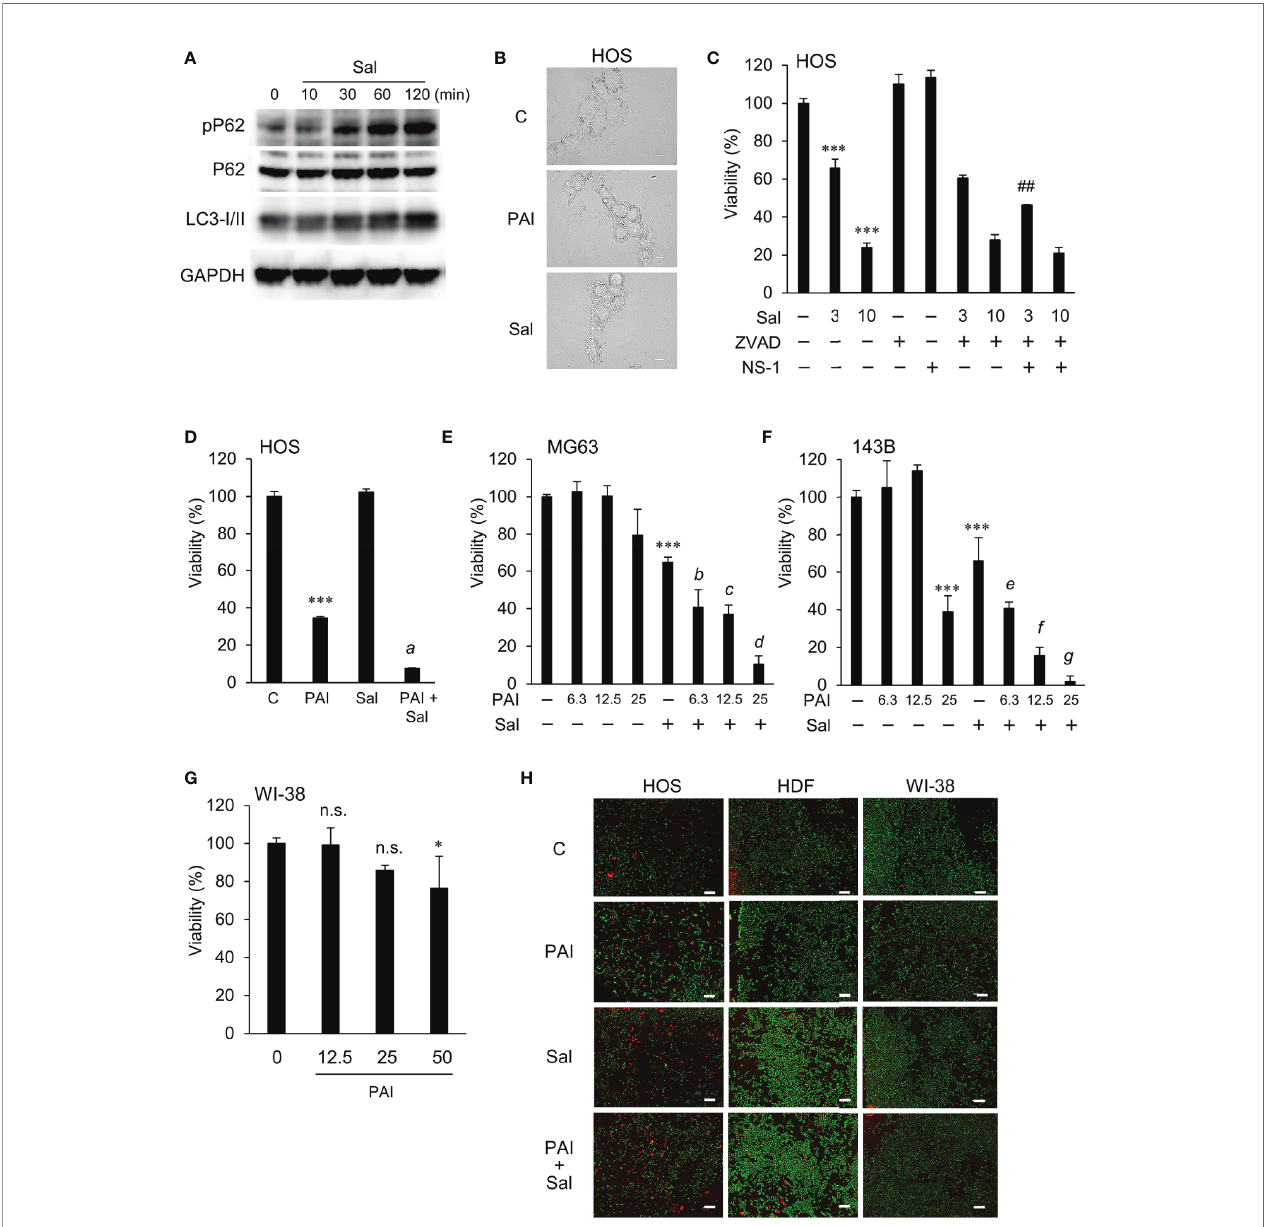
FIGURE 4 | PAI and Sal mutually act as adjuvant in a tumor-speci fi c manner. (A) LM8 cells were treated with Sal (1 m M) for the indicated time and then analyzed for the expression of phosphorylated P62, P62, and LC3-I/II by western blotting analysis using speci fi c antibodies. GAPDH was used as the loading control. See Supplementary Figure 5 for examples of uncropped images and quanti fi cation for each antibody. (B) HOS cells were treated with PAI (25%) and Sal (3 m M) for 18 h and observed under a BZX-710 digital biological microscope equipped with a 100×coverslip-corrected oil objective and were analyzed using BZ-H3A application software. Bar = 10 m m. (C) HOS cells were treated with Sal (3, 10 m M) alone or in combination with ZVAD-FMK (ZVAD, 10 m M) or necrostatin-1 (NS-1, 30 m M) for 72 h, and were measured for cell viability using the WST-8 assay. (D) HOS cells were treated with PAI (25%) and Sal (1 m M) alone or in combination for 72 h and were measured for cell viability using the WST-8 assay. Data were analyzed by one-way analysis of variance followed by Tukey ’ s post hoc test. *** P < 0.001 vs. control; a , P < 0.001 vs. PAI or Sal alone. (E, F) (E) MG63 and (F) 143B cells were treated with PAI at the indicated concentrations and Sal (3 m M) alone